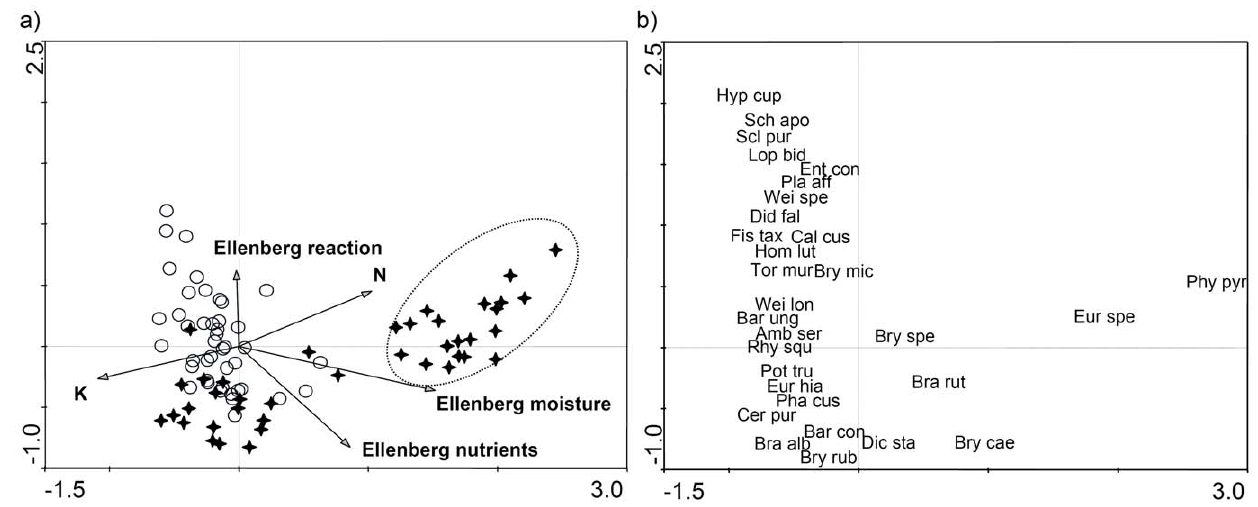
Figure 3. CCA-ordination of bryophyte species richness and environmental variables for stands (a) and species (b). CCA-ordination of bryophyte species and environmental factors in grasslands (n=83). Stands and environmental factors (a) and species (b) of the same ordination are plotted separately to ease readability. Hainich-Du¨n: open circles; Schorfheide-Chorin: stars. Plots in the dotted circle are situated on either Gleyosols or Histisols. N and K are nutrient concentrations in aboveground vascular plant biomass and Ellenberg indicator values given are gained from vascular plant vegetation. Longer vectors indicate stronger correlations between variables and axes. See Table 1 for further details on single variables.